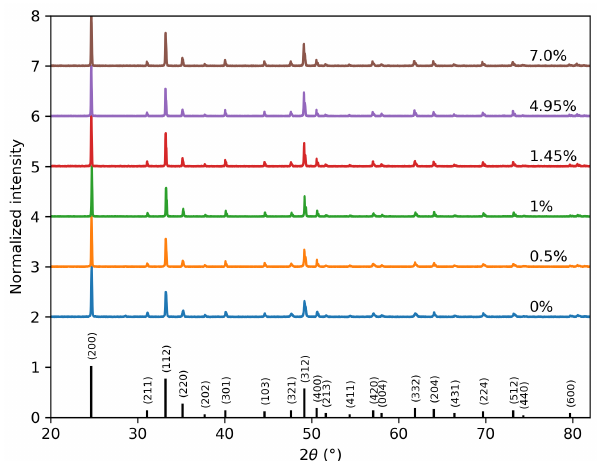
Figure 1. PXRD pattern of GdVO 4 from all the concentrations of the GA series. Concentrations are those obtained by the EDX measurements except for 0%, 0.5%, and 1%. Bottom: expected lines (GdVO 4 , PDF number: